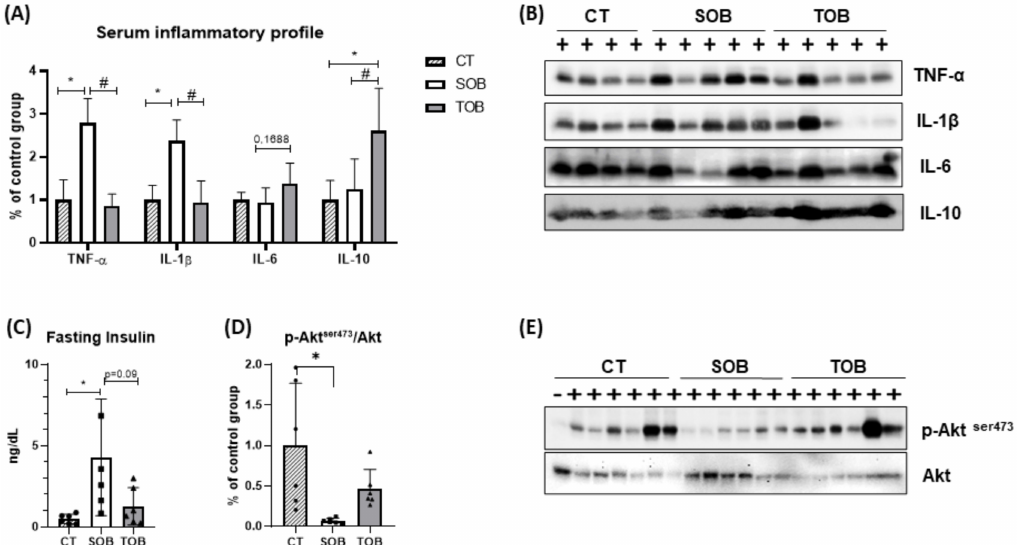
Figure 2. Biomolecular parameters. ( A ) Interleukin-1 beta (IL-1 β ), tumor necrosis factor-alpha (TNF- α ), IL-6, and IL-10 content in the serum. ( B ) Band of proteins measured by immunoblotting in serum. ( C ) Fasting insulin (8 h fasting). ( D ) Phosphorylation of protein kinase B (Akt) in liver tissue. ( E ) Band of proteins measured by immunoblotting in the liver tissue. The bars represent the mean ± SD of the control (CT), sedentary obese (SOB), and trained obese groups (TOB) ( n = 4–6 per group). * p < 0.05 vs. CT; # p < 0.05 vs. TOB. The Gaussian distribution of the serum and liver data samples was assessed using the Shapiro–Wilk test to perform Dixon’s one-sided outlier test with p < 0.05. One-way ANOVA non-parametric test was performed, followed by Tukey’s post-hoc test ( A , D ) and Bonferroni’s post-hoc test ( C ), considering p < 0.05 as statistical